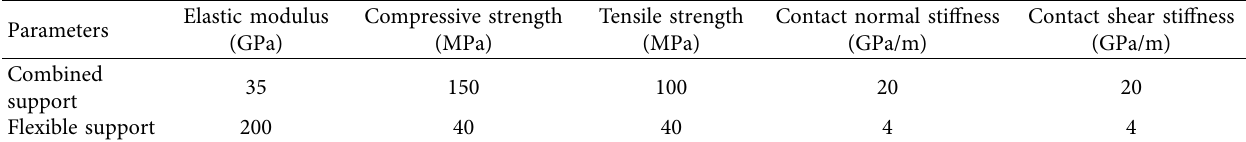
Table 5: Properties of the structure elements in the